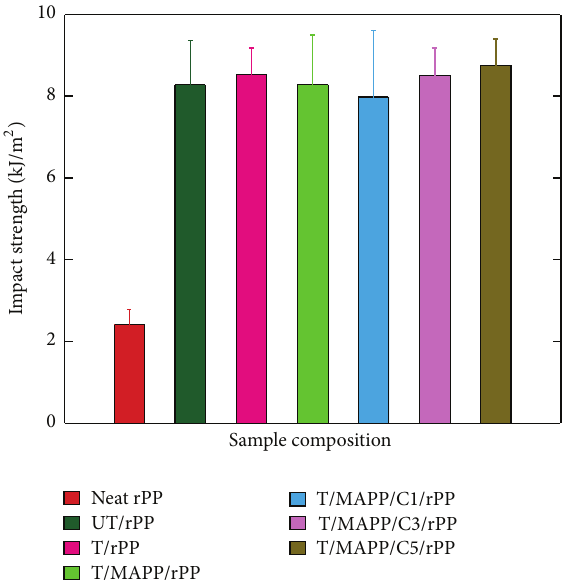
Figure 4: Impact strength of sisal fiber and nanoclay reinforced polypropylene